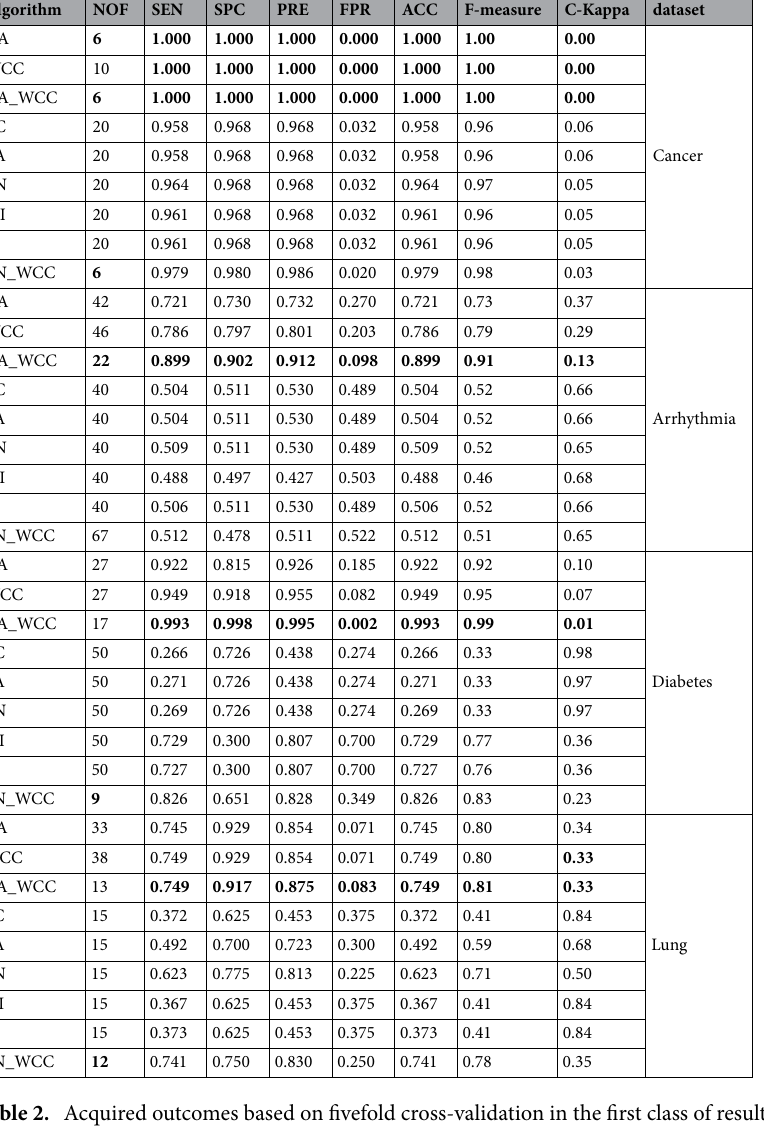
By applying the algorithms, the value of accuracy improved for the CHD and SHD datasets and remains unchanged for the PID dataset. Further, the total number of features is remarkably reduced. Thus, the obtained models obtained by applying the algorithms operate faster than the model, which uses all the existing features. Having compared GA and WCC algorithms, WCC was seen to lead to a model with lower number of features and higher values of criteria. Therefore, it might be concluded that the state- of-the-art optimization algorithm can get more acceptable data than others. (iii) The third category of the results: In this section, the outcomes of the methods and algorithms are evalu- ated on the regression-based dataset (WDBC and drug datasets). To this end, the criteria such as root mean squared error (RMSE) and the correlation between predicted and real labels were calculated and gathered (Table 7). For the filter FS methods, different numbers of features have been tested, and then, their best results were reported. For the wrapper FS approaches, it is not necessary to limit the total number of features and they can regulate it. Even so, they produce variable results in their different executions, so they must be executed at least 30 times and their best-obtained outcomes among from the executions (different accuracy values of the executions) are reported as a solution to the problem. Thus, several criteria were reported for them, based on the acquired results in 50 individual executions, including confidence interval (CI), p-value, standard deviation (STD), etc.